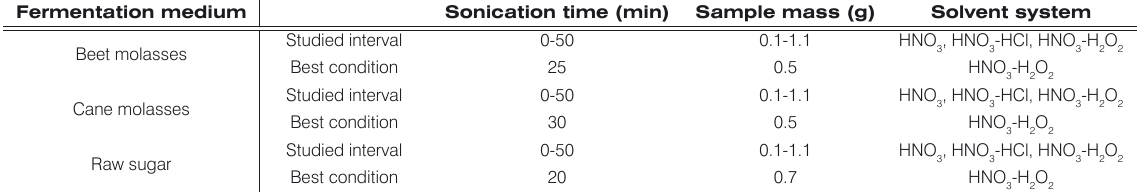
Table 2. Operating conditions for ultrasound assisted pseudo-digestion of Fe and Mn from CAFMs samples.